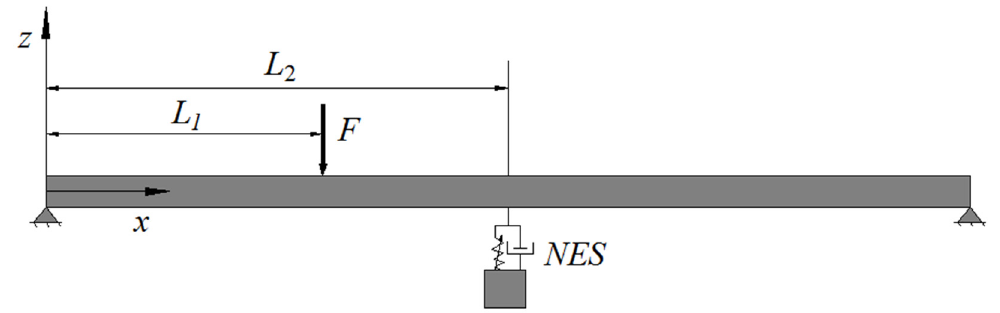
Figure 2. Simply supported beam attached to an